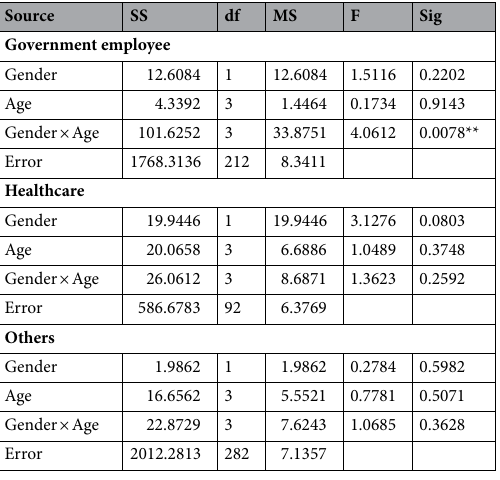
Table 15. Simple interaction effect of occupation and strengthening one’s immune system. ** p <